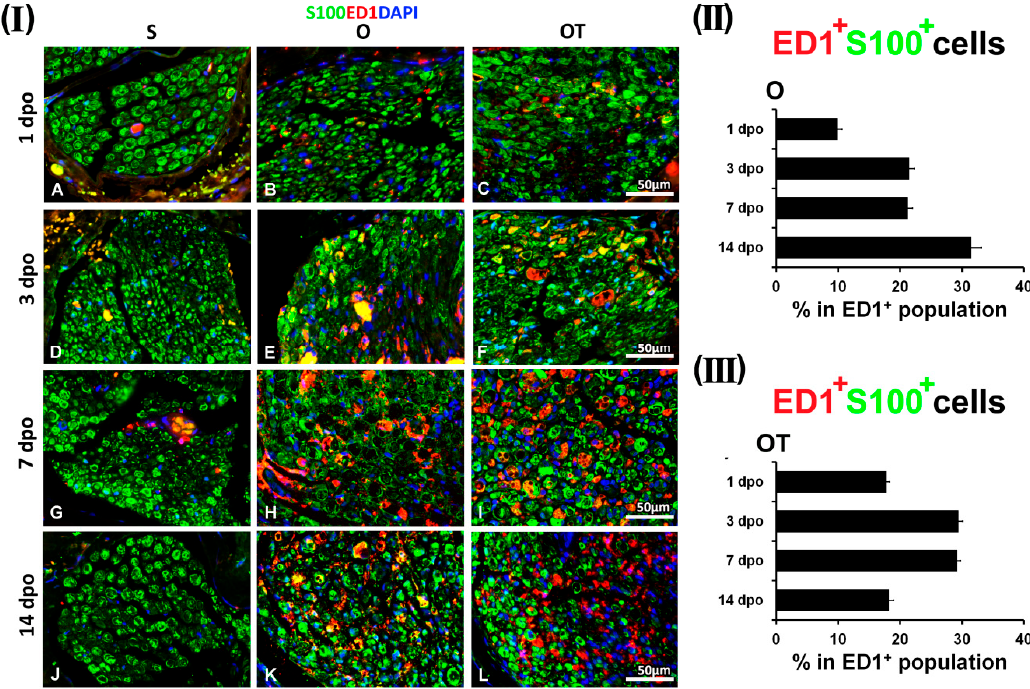
Figure 6. Time course immunohistochemical analysis of macrophages/SCs co-localization after PNI and the treatment with B vitamins. ( I ) Comparative analysis of macrophages/SCs crosstalk in the cross sections of the femoral nerve obtained from the sham (S) group at different time points ( A —1